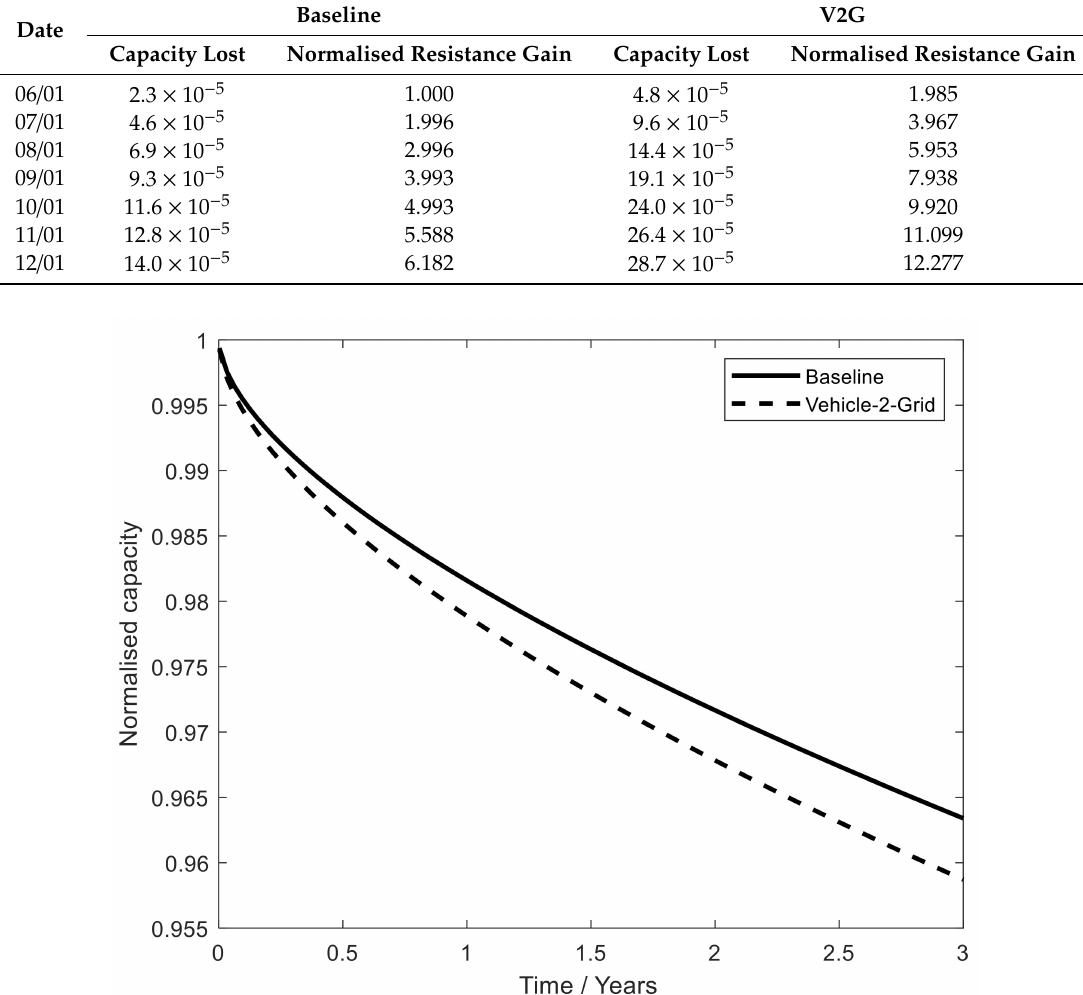
Table 1. Cumulative results of both simulations across a week (6 January 2020–12 January 2020).